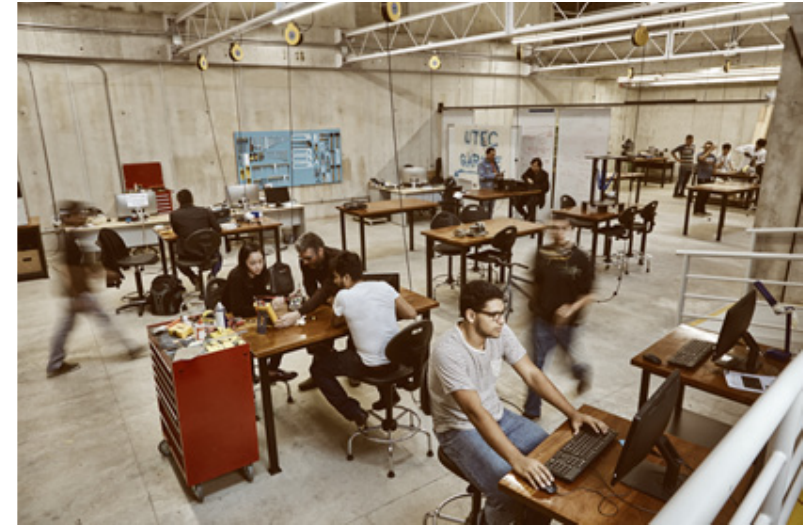
Fig. 6. UTEC Garage as a MakerSpace lying at the heart of Moray. This 250 m 2 -large space is open around the clock to allow students, faculty and external stakeholders to gather in groups and develop prototypes of different levels of fidelity for their diverse projects. It is also a space for transdisciplinary workshops and roundtable